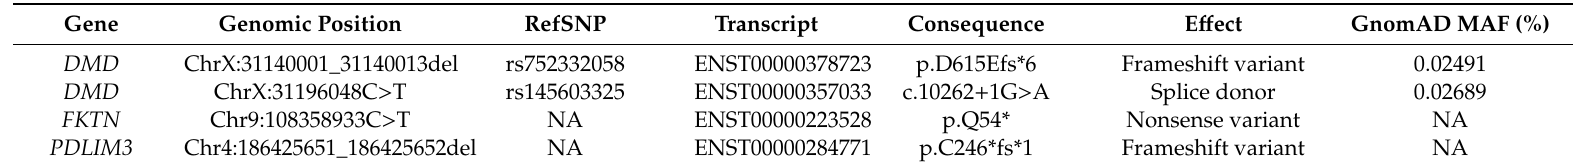
Table 3. Loss-of-function variants identified in cytoskeletal